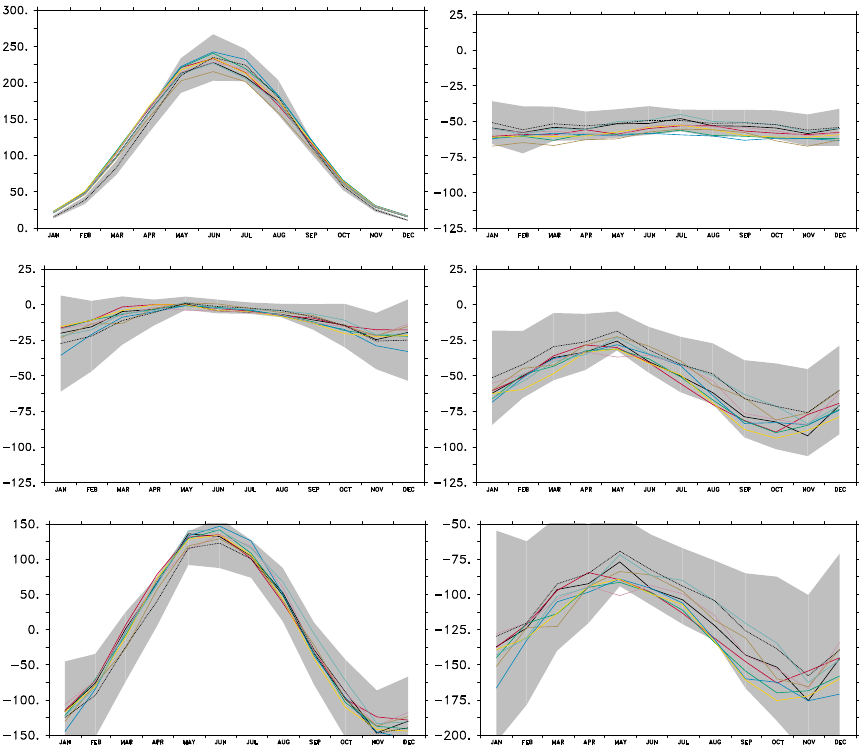
Figure 4. Climatological seasonal cycles averaged over the North Sea for shortwave radiation (W/m 2 ) ( upper left ), longwave radiation (W/m 2 ) ( upper right ), sensible heat flux (W/m 2 ) ( middle lef t), latent heat flux (W/m 2 ) ( middle right ) net heat flux (W/m 2 ) ( lower left ), non-solar heat flux (W/m 2 ) ( lower right ) for different RCA4-NEMO experiments during the years 1970 to 1989. The dotted, black line, and the shaded area are derived from the ASMD94 dataset. The shading indicates the 95% confidence limits. The black (light blue) lines apply to the coupled (ocean only) ERA40 hindcasts. The six other curves denote the results of the RCM driven with MPI-ESM-LR (red), EC-EARTH (green), GFDL-ESM2M (blue), HadGEM2-ES (yellow), IPSL-CM5A-MR (rose), ECHAM5 (olive),